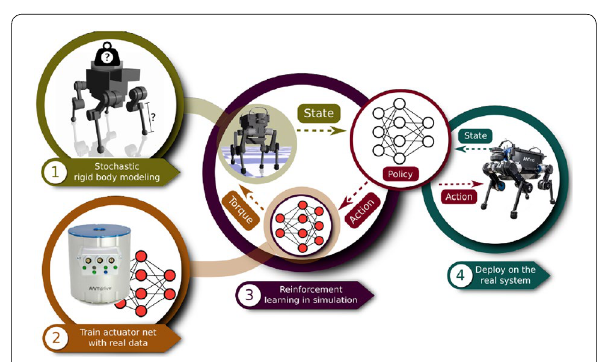
Figure 20 Sim-to-real RL control architecture for ANYmal [3]